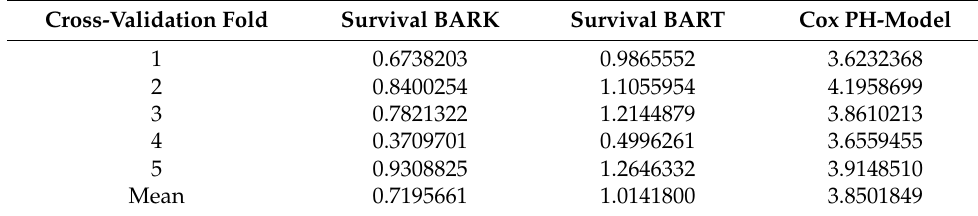
Table 2. RMSE from 5-fold cross-validation performance of Survival BARK, Survival BART, and Cox-PH Model on the kidney catheter